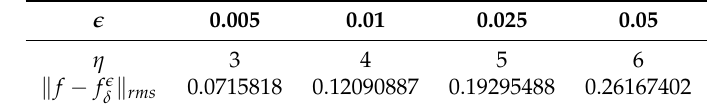
Table 5. Error norms, α = 0.7.